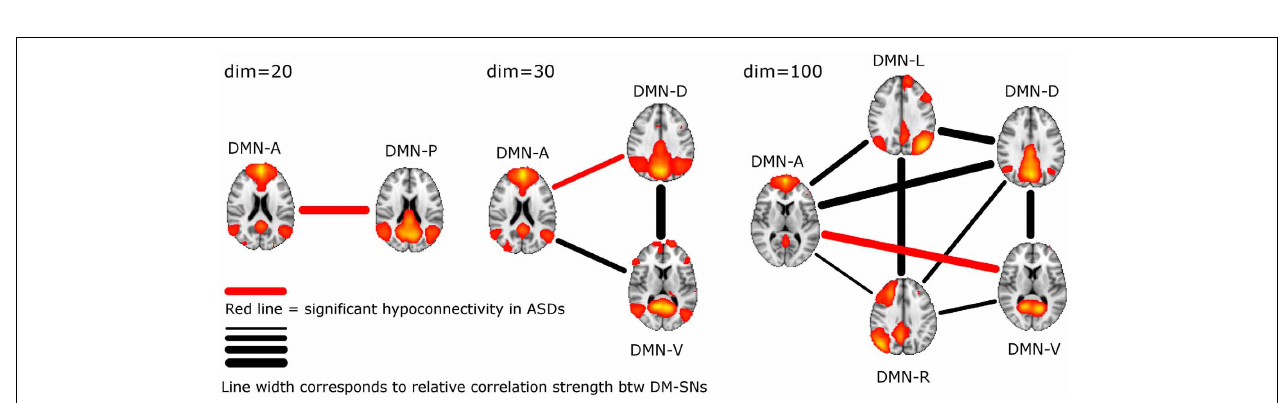
FIGURE 2 | The lines between DM-SNs illustrate the tested connections on varying ICA dimensionalities between the participants with ASDs and TDs. The red line denotes statistically